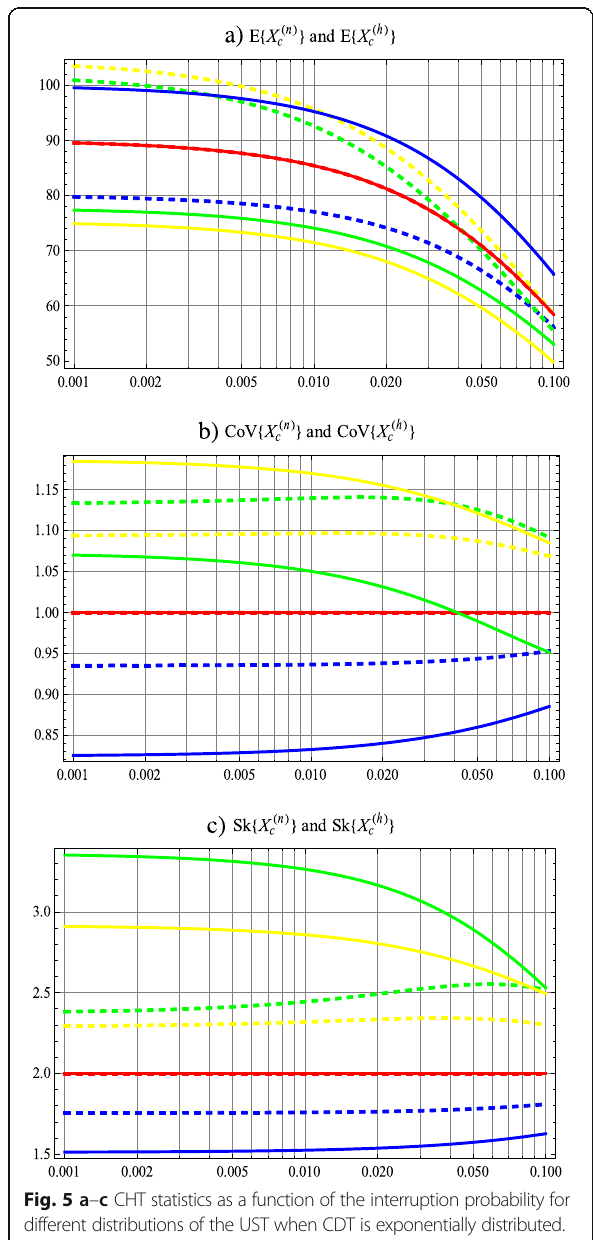
Fig. 5 a – c CHT statistics as a function of the interruption probability for different distributions of the UST when CDT is exponentially distributed. In this figure, red , blue , yellow , and green lines represent the scenarios where the UST is exponentially, Erlang, hyper-exponentially of order 2, and hyper-Erlang of order (2, 2) distributed, respectively. Solid-lines ( dashed-lines ) corresponds to CHTn (CHTh)